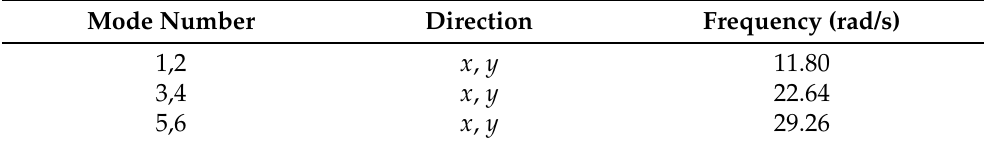
Table 2. Linear sloshing natural frequencies—Case study